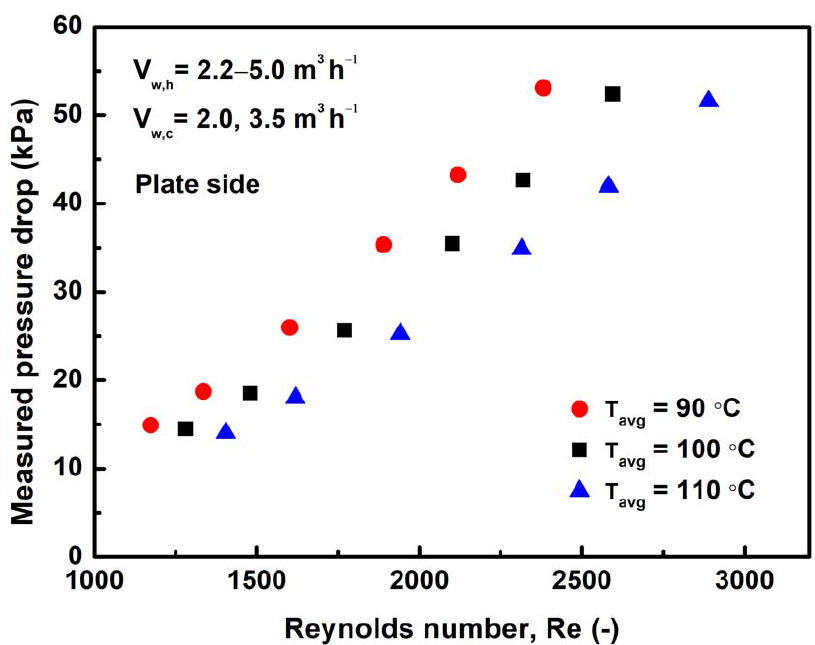
Figure 9. The pressure drop on the plate side with respect to thee Re and average temperature in PSHE. Figure 10 compares the f for water on the plate and shell sides of the PSHE with respect to the Re. The f on the plate side decreased with an increase in the Re on the plate side owing to the increased mass flux, which was the general trend observed in PHEs [8,20,21]. However, the f on the shell side slightly increased with an increase in the Re on the plate side owing to the decreased mass flux on the shell side with the dispersed upward flow.